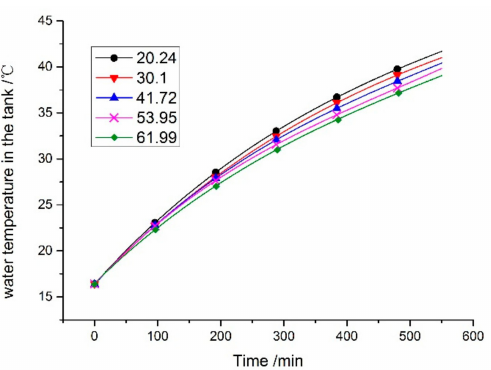
Figure 6. Curve of average water temperature in the water tank with time for di ff erent PCMs.